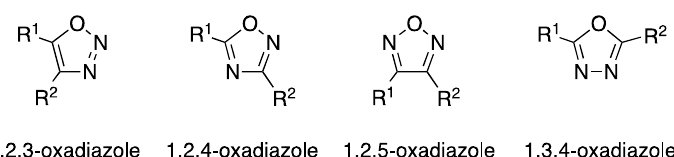
ff erent oxadiazole